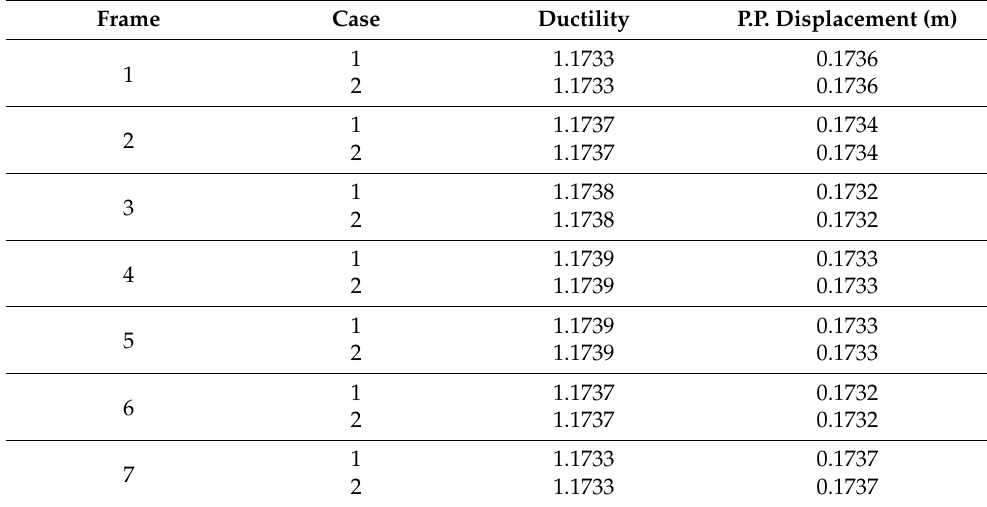
Table 6. Results of the pushover analysis including the load of the overhead